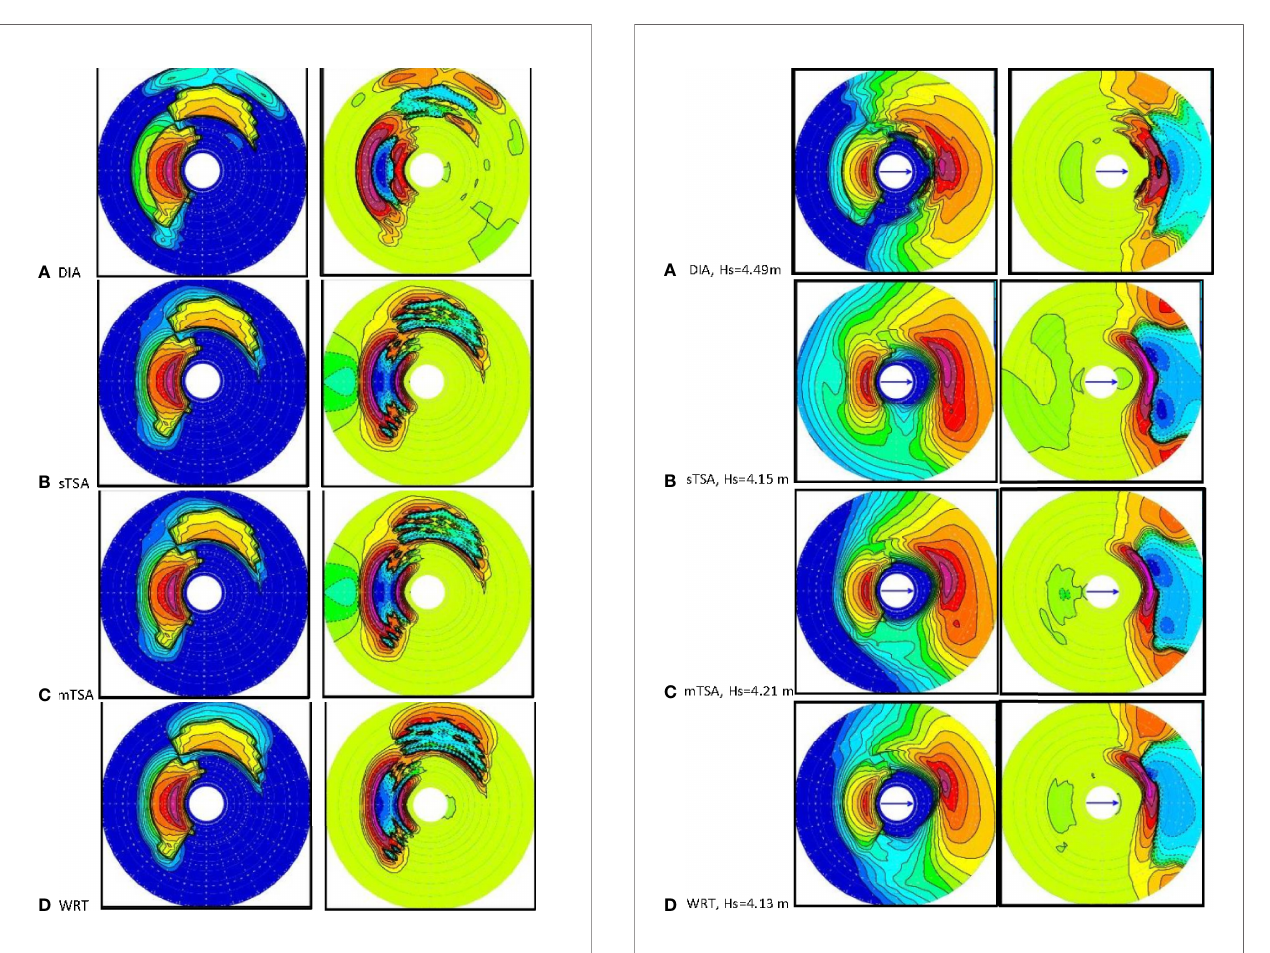
FIGURE 2 | Evolving spectra starting with initial conditions as Figure 1 , after time of 5 hours evolution, with no wind: (A) DIA, (B) single-TSA, or sTSA, (C) multiple TSA, or mTSA, (D) WRT, showing 2-D energy in the left column and 2-D S nl in the right. Same color bars and scales as Figure 1 . Hs remains constant. Total energy is conserved; Hs is 2.12m.